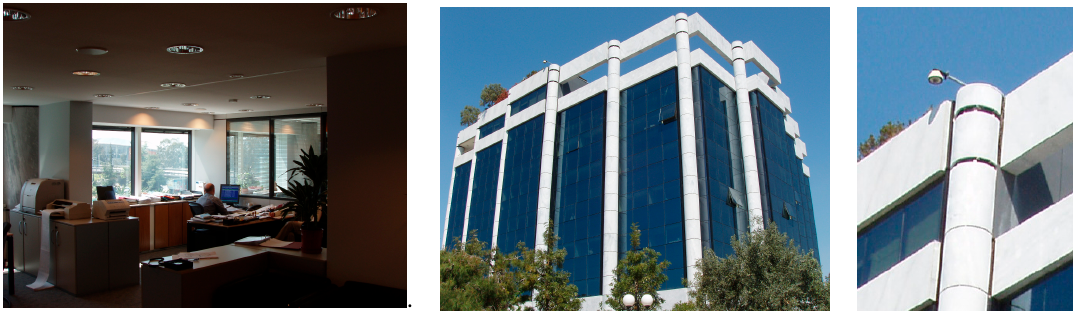
Figure 3. Interior space ( left ), exterior façade ( middle ) and position of the photosensor ( right ) for Building B.